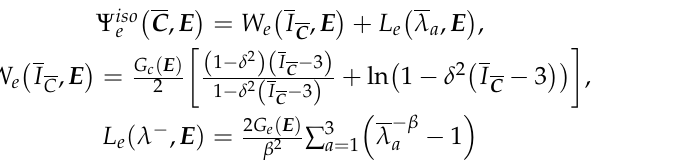
Figure 4. Schematic representation of the inserts for the insert holders with a DEA sample shows the contacting of the compliant electrodes.